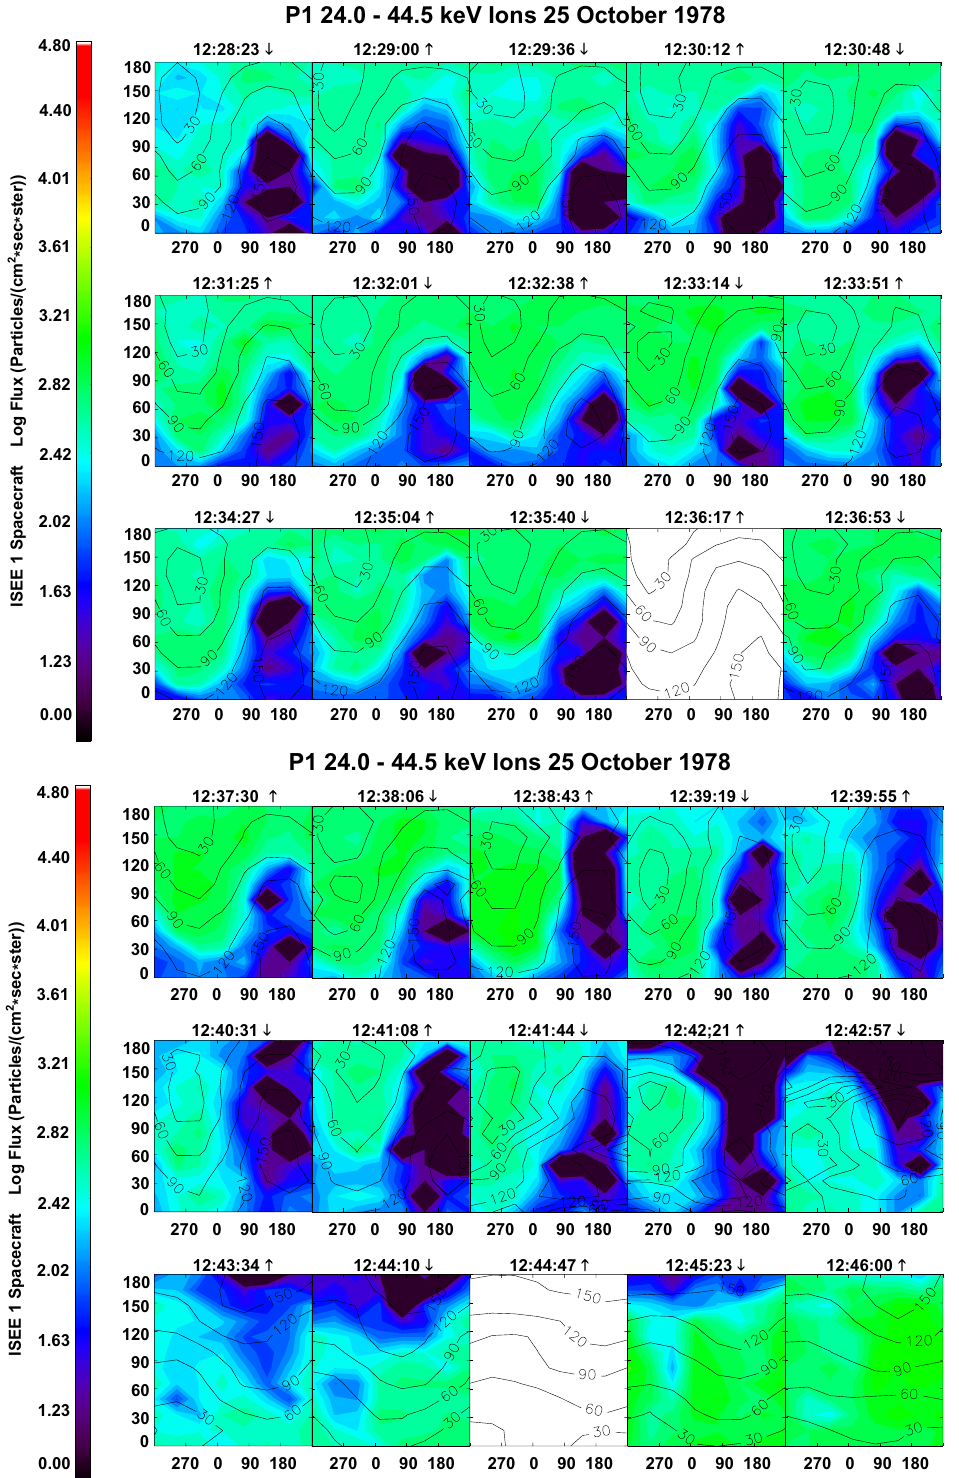
Fig. 5. A time sequence of three-dimensional PADs for the ISEE-1 Medium Energy Particles Experiment P1 channel which measured 24 to 44keV ions on 25 October 1978 (Day298). Panel (a) shows a sequence of fifteen angle/angle plots from 12:28:23UT to 12:36:53UT demonstrating the northern hemispheric PADs. Panel (b) shows the next sequence of these plots from 12:37:30UT to 12:46:00UT in which the magnetopause current layer was crossed. The small arrows at the top of these angle/angle plots (and subsequent plots) indicate the direction of the vertical scan motion of the WAPS